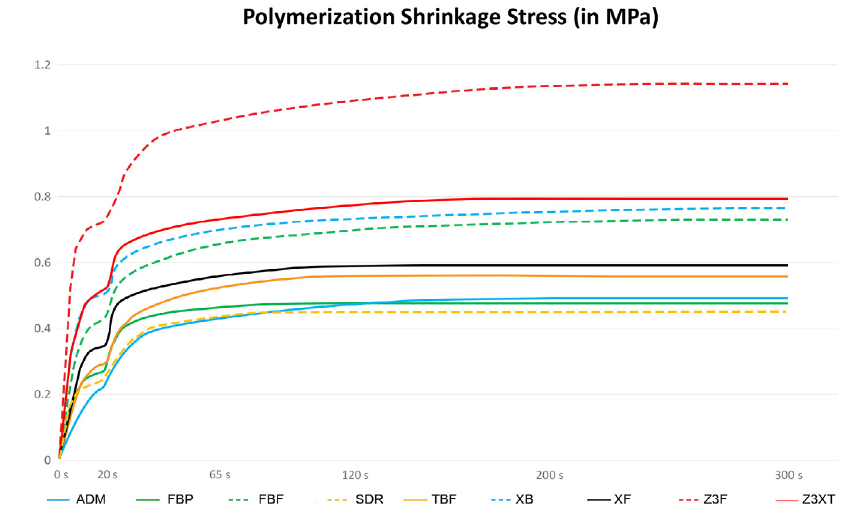
Figure 3- Stress development (in MPa) among the different composites (24 mm 3 )